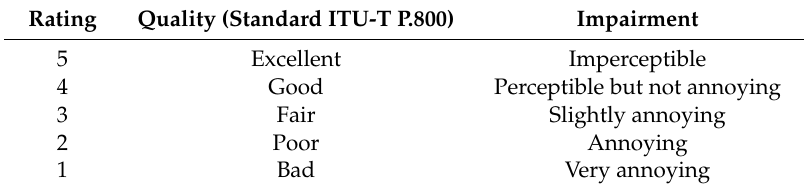
Table 3. The numerical scores for the mean opinion score (MOS) criteria in the evaluation